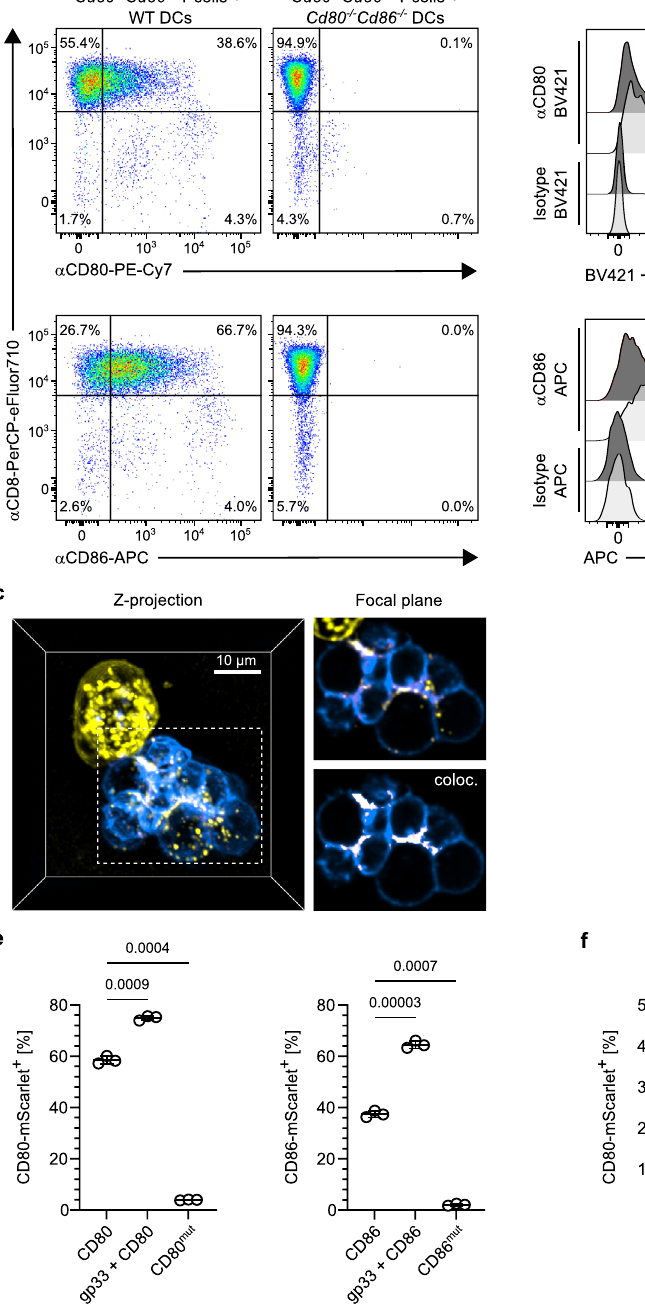
transfer of CD80 and CD86uponaddition of CTLA4-Fcto CD8 + T cells co-cultured with CD80- or CD86-mScarlet expressing MEFs. See also Figure S1 and Movie S1. Statistics: b : Pooled data from 4 independent experiments. Two-sided Wilcoxon matched-pairs signed rank test. p -values: CD80 spleen 0.0001 ( n =14